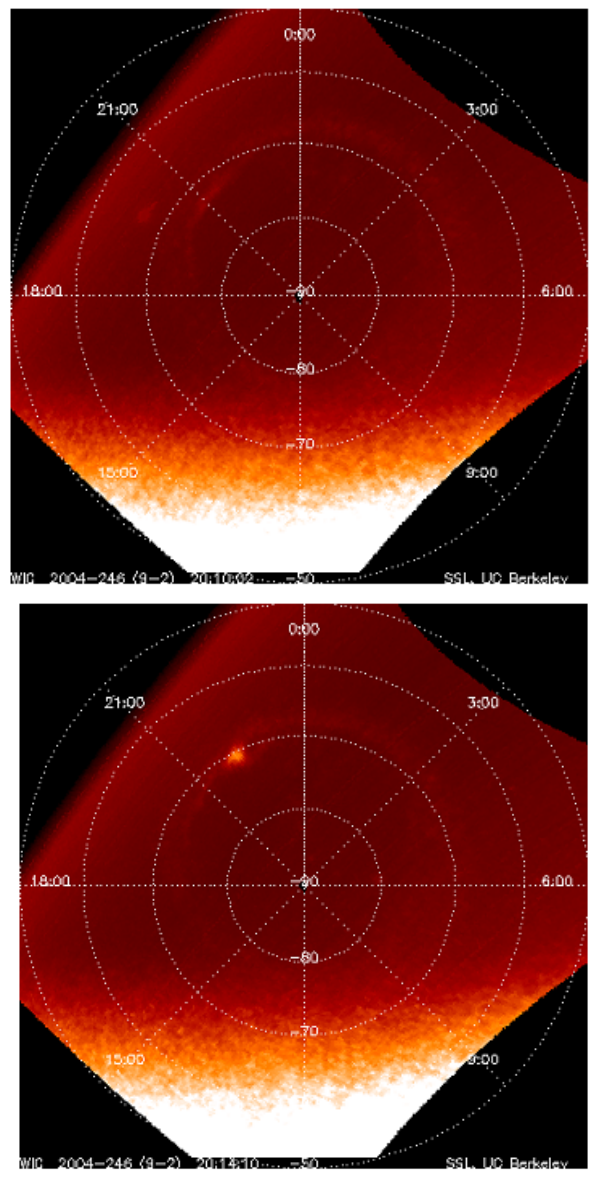
Fig. 2. Auroral images from south polar region taken by IMAGE FUV-WIC at the times 20:10:03 and 20:14:10 UT on 2 September 2004. The images are presented in the frame of MLat and MLT coordinates. The bright spot in the right frame marks the substorm